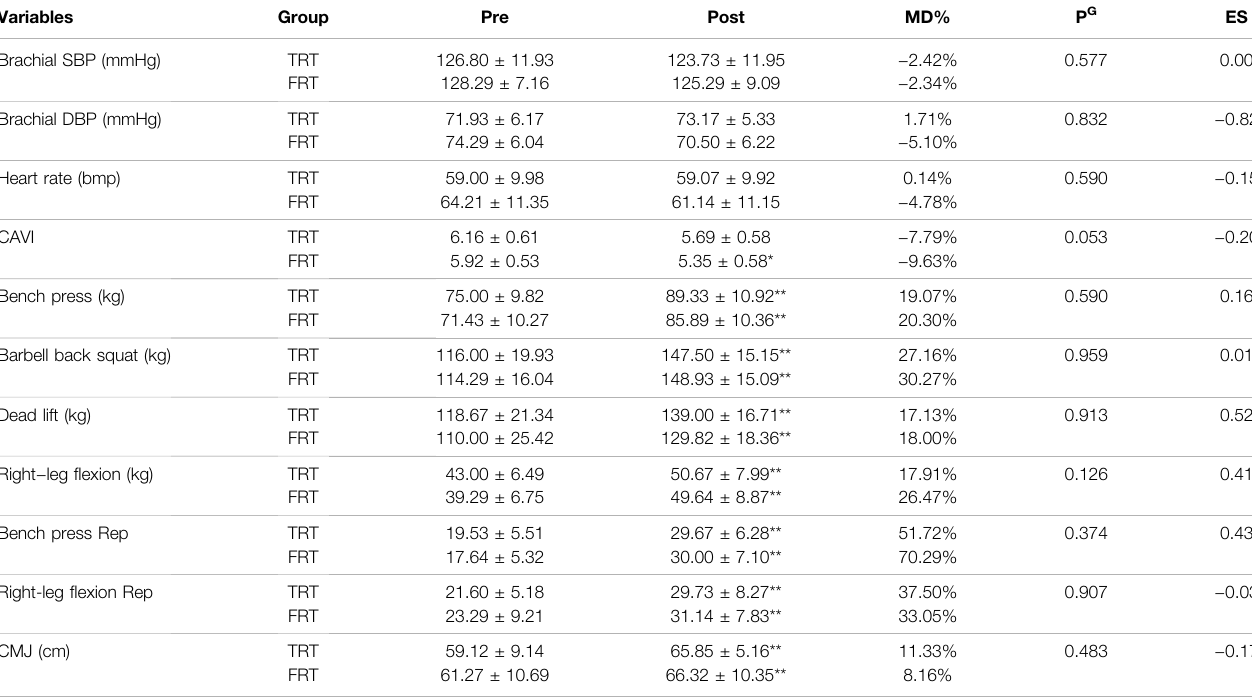
TABLE 2 | Comparison of arterial stiffness, blood pressure, heart rate and muscular fi tness between groups and effect sizes as Cohen d. Variables